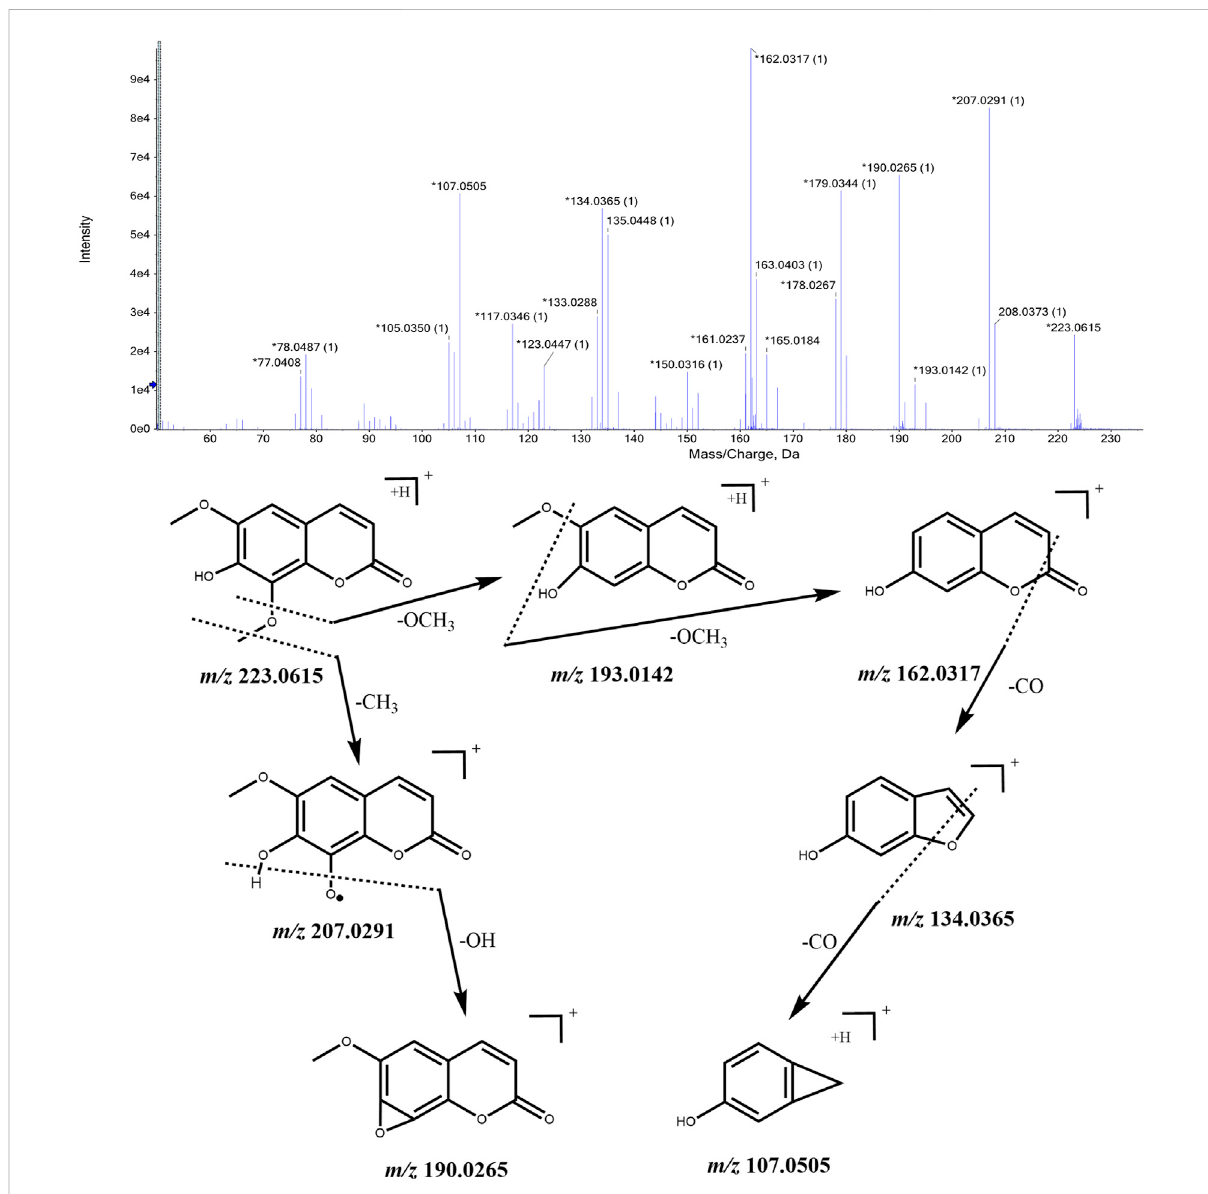
FIGURE 5 MS/MS spectrum of isofraxidin in CWT and speculated fragmentation